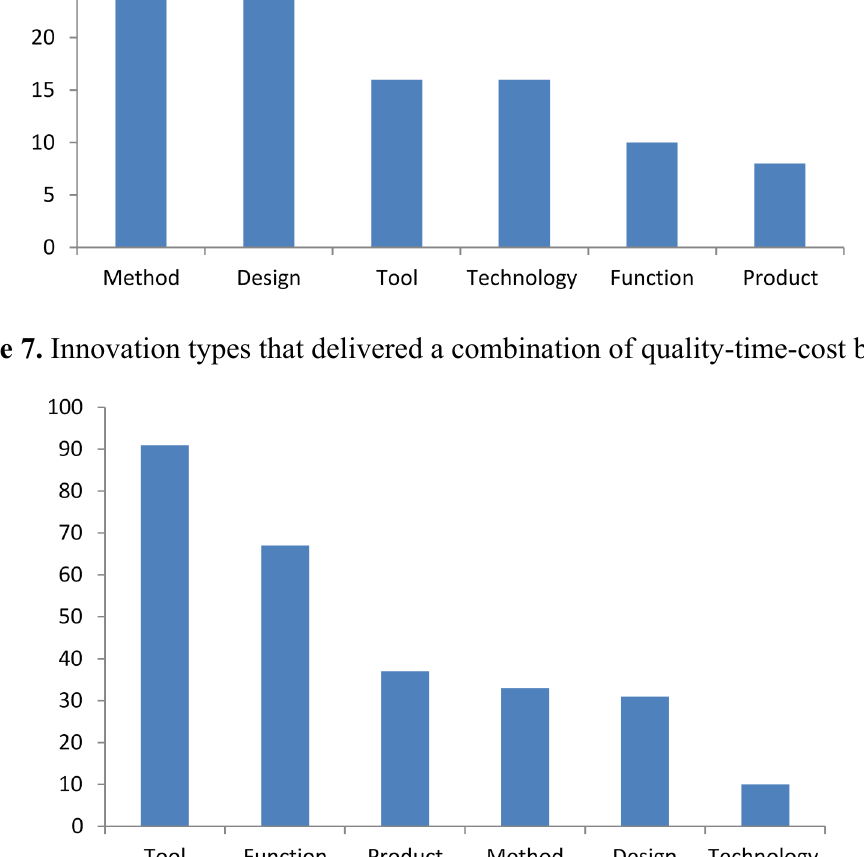
Figure 8. Innovation types that focused on delivering a single benefit.